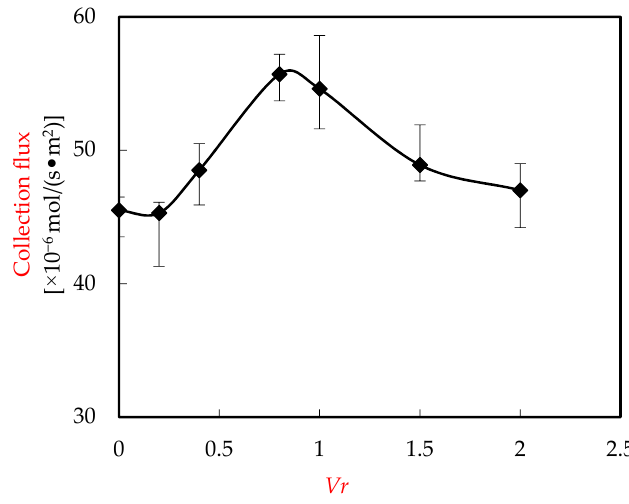
Figure 9. Influence of Vr .